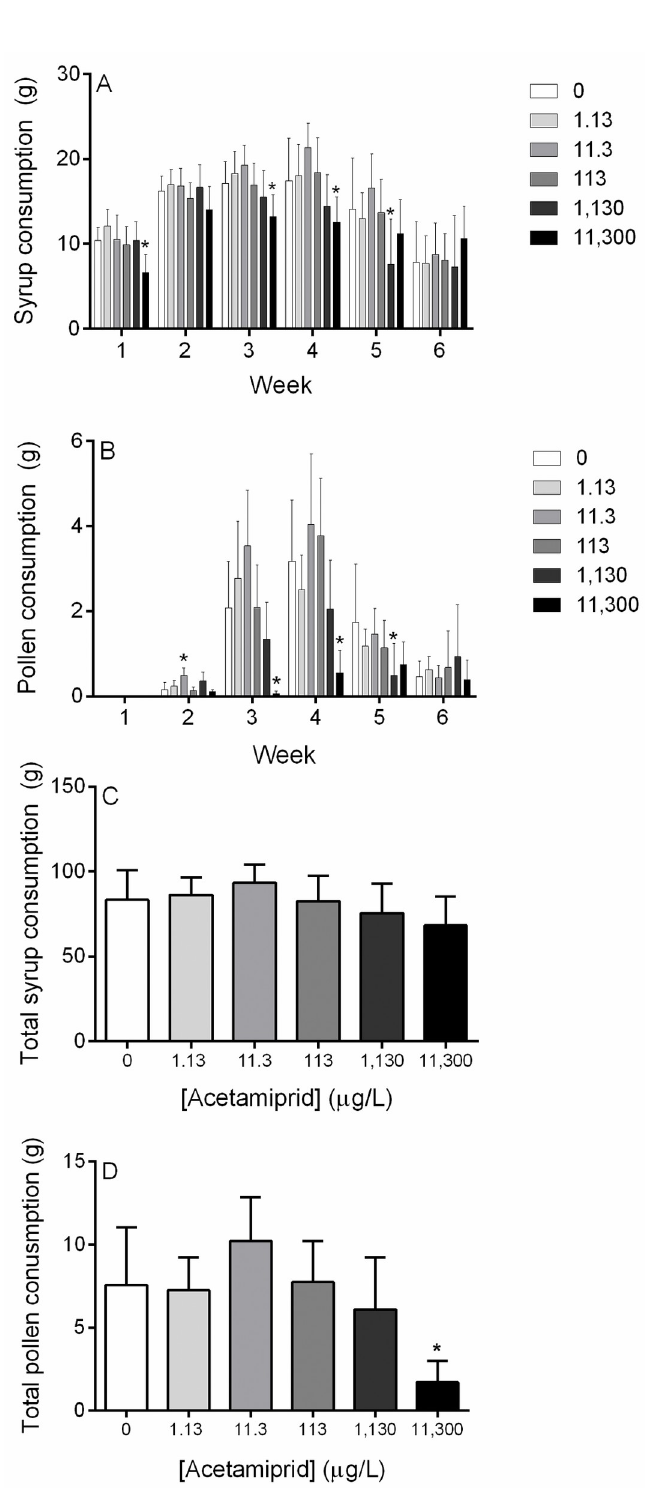
Fig 4. Microcolony syrup and pollen consumption. ( A ) Average syrup consumption by exposure group per week. ( B ) Average pollen consumption by exposure group per week. ( C ) Average syrup consumption over 6 weeks for each exposure group. ( D ) Average pollen consumption over 6 weeks for each exposure group. Pollen consumption tracking began during week two of the experiment. All values have been corrected for evaporation. Acetamiprid concentrations are expressed in μ g/L. Data shown as mean ± SD (n = 10). � denotes p < 0.05.